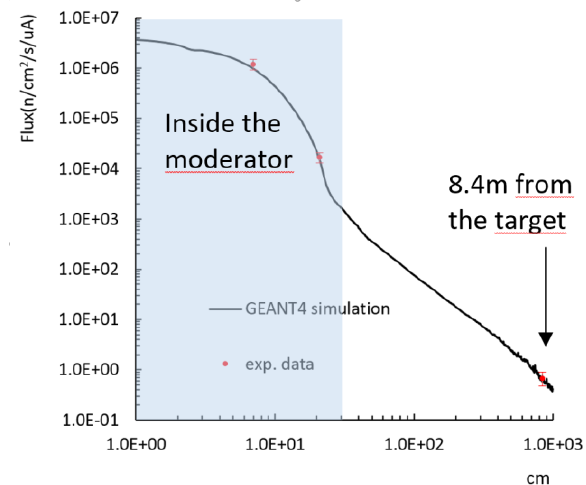
Fig. 7. Thermal neutron flux (less than 0.4 eV) as function of the distance between the target and 3He counter given by Geant4 simulation and compared with measurements. Measured flux inside the moderator using the gold foil activation technics and outside the moderator using 3 He